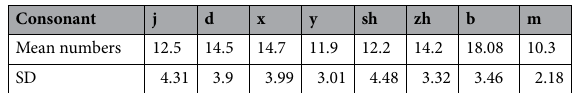
Table 1. Number of words generated in the pre-experiment.